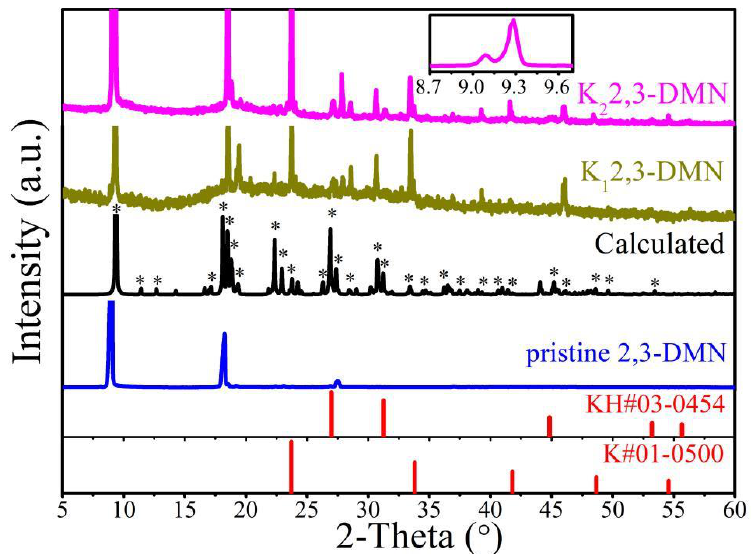
Figure 2. XRD of pristine and potassium-doped 2,3-DMN. “Calculated” represents the calculated XRD of theoretical structure in Section 3.4. “*” represents the calculated peak position consistent with the peak of the experimental curve. The illustration showed the K 2 2,3-DMN sample data information between 8.7 ◦ and 9.7 ◦